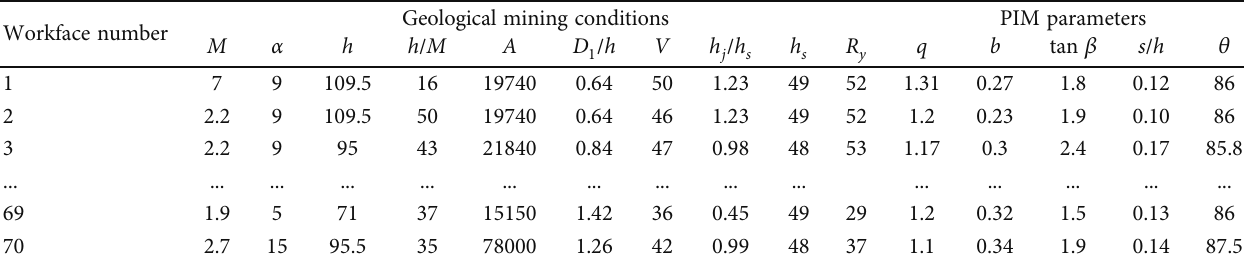
Table 1: Experimental data.